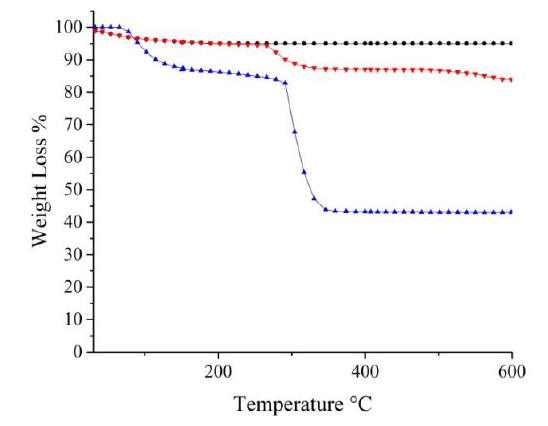
Figure 3. TGA curves of RE TiO 2 NPs (black line), TiO 2 -PHA (red line), and TiO 2 /HKUST-1 (blue line). Selected area electron diffraction (SAED) analysis was in agreement with XRD and high- resolution TEM (HRTEM) data, confirming again the presence of TiO 2 anatase phase in both TiO 2 - PHA and TiO 2 /HKUST-1 samples and of crystalline HKUST-1 in the hybrid system, as revealed by lattice fringes analysis (Figure S1). Finally, STEM-EDS analysis reveal the presence of Ti and Cu with a ratio close to the theoretical 1:1 (Figure S2).